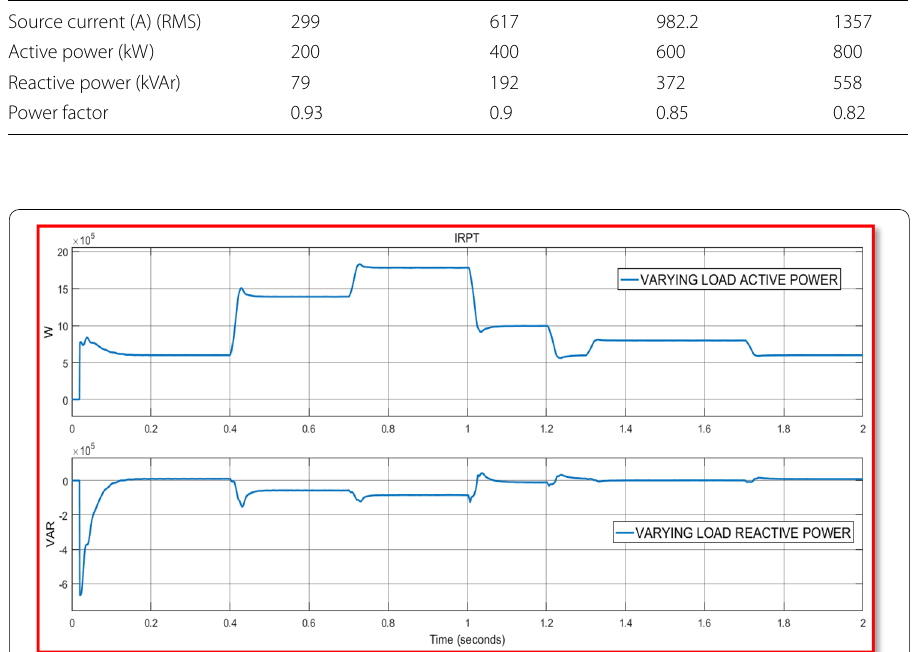
Fig. 13 Varying load active and reactive